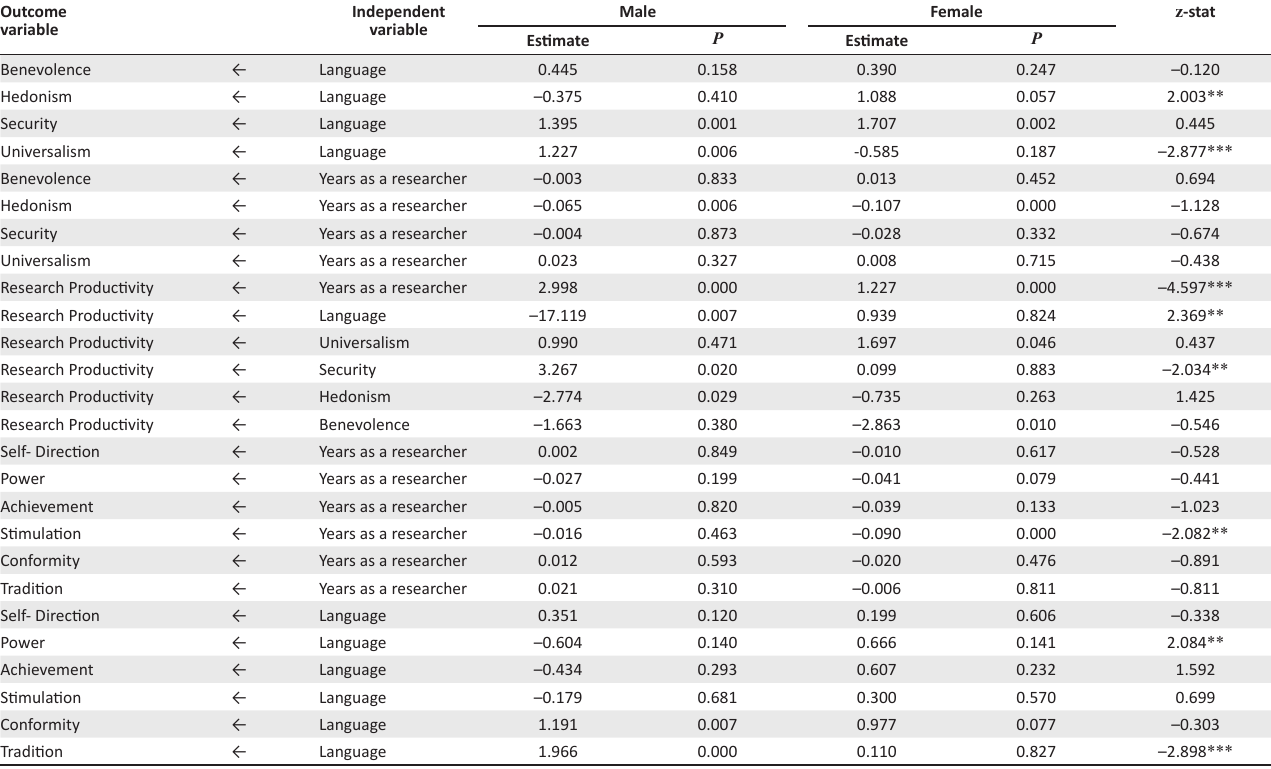
TABLE 7: Critical ratio tests of path differences by gender. Outcome